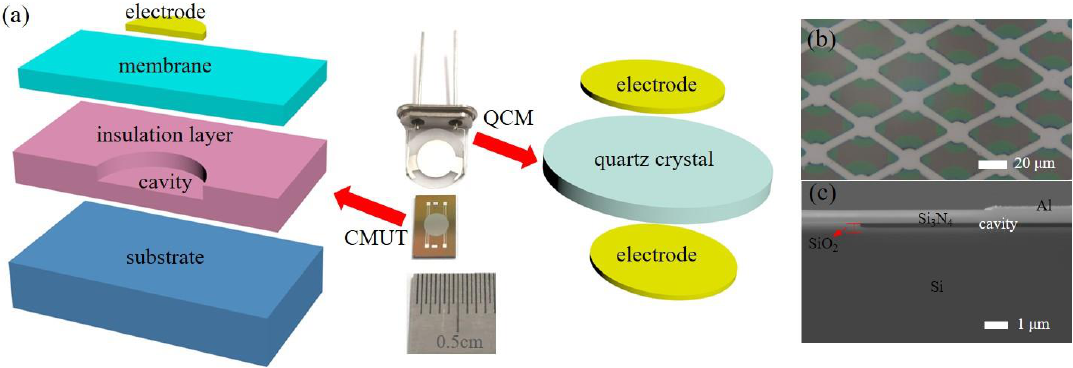
Figure 1. ( a ) Photograph of the CMUT and the QCM (middle); schematic of half the structure of a CMUT unit (left); schematic of the structure of a QCM (right); ( b ) microscopic image of the fabricated CMUT; ( c ) SEM image of the cross-section of the CMUT unit.